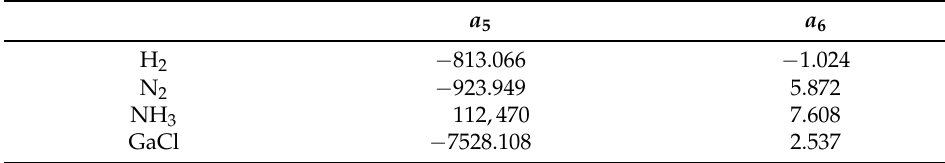
Table A2. Integration constants for C high p for each